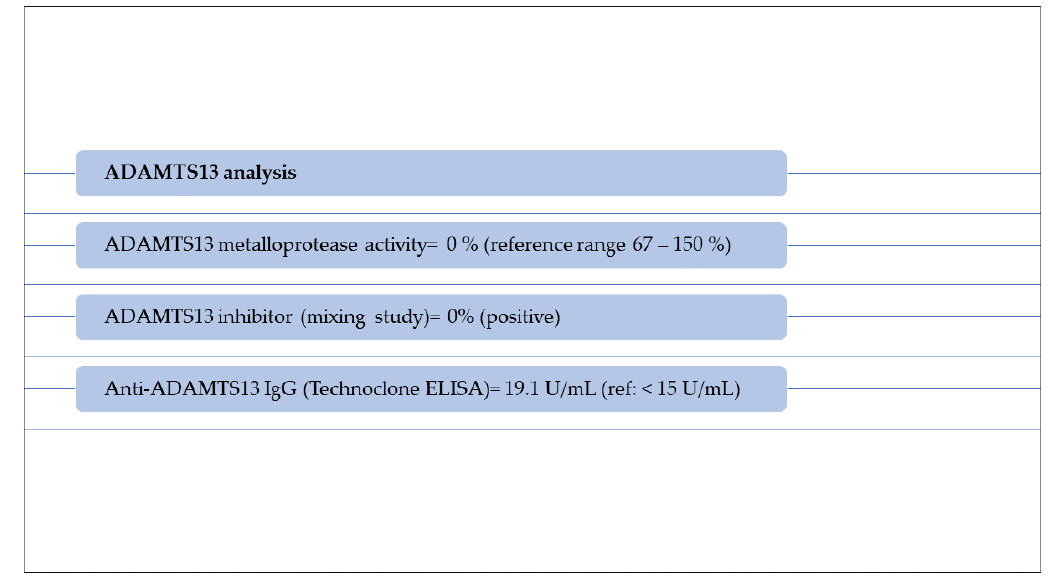
Figure 3. ADAMTS13 analysis in a patient suspected with TTP. Table 5. Total complement activity analysis before treatment initiation for TTP.